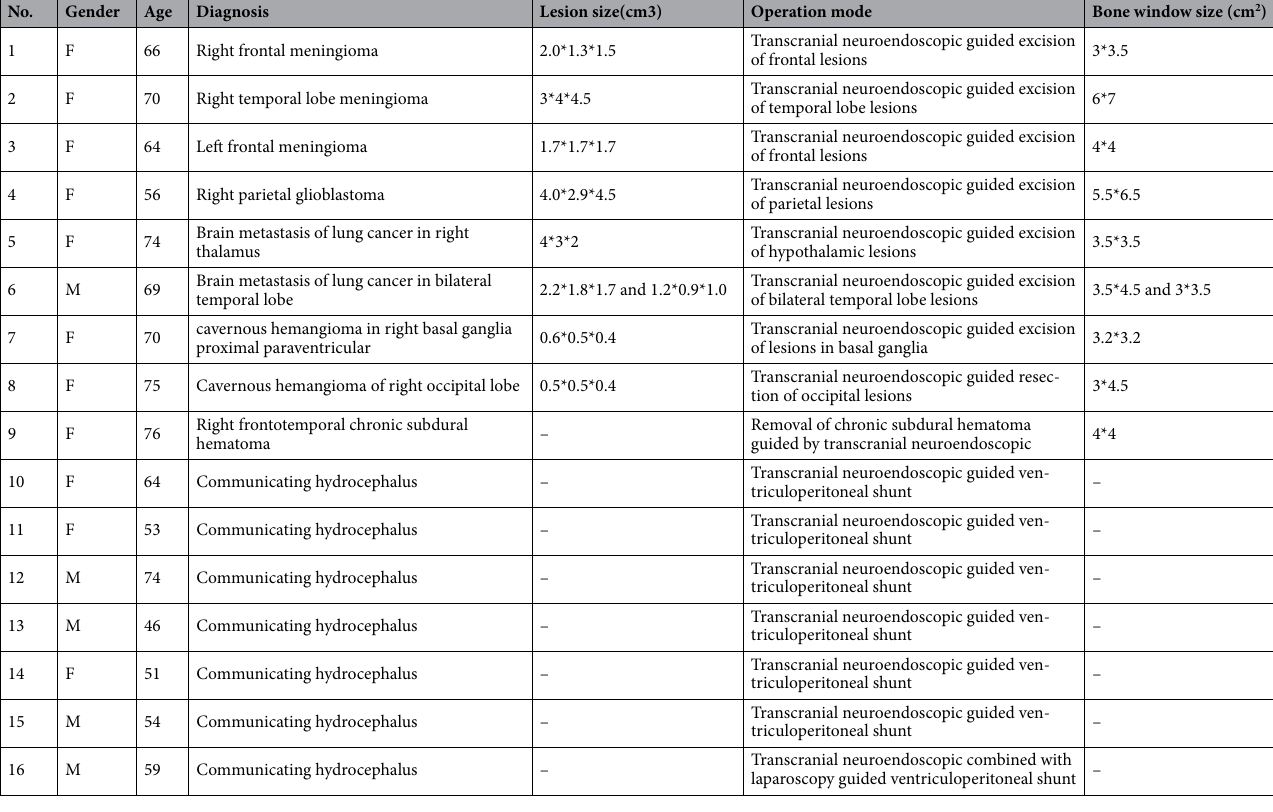
Table 1. Clinical